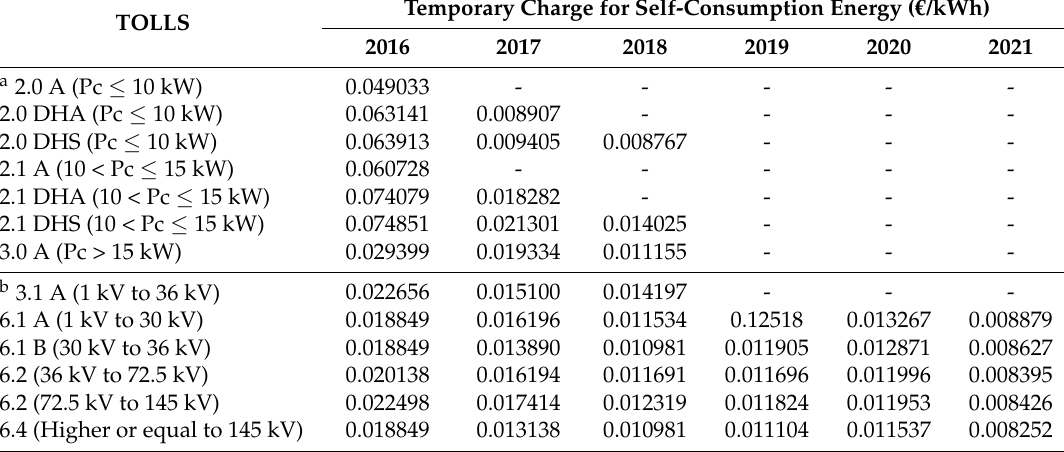
Table A1. Taxes for self-consumption of renewables (from January